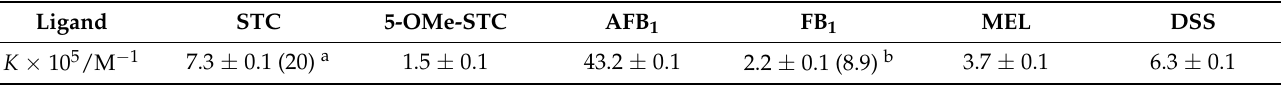
Table 1. Binding constants of AuNC@BSA/ligand = 1:1 complexes determined.